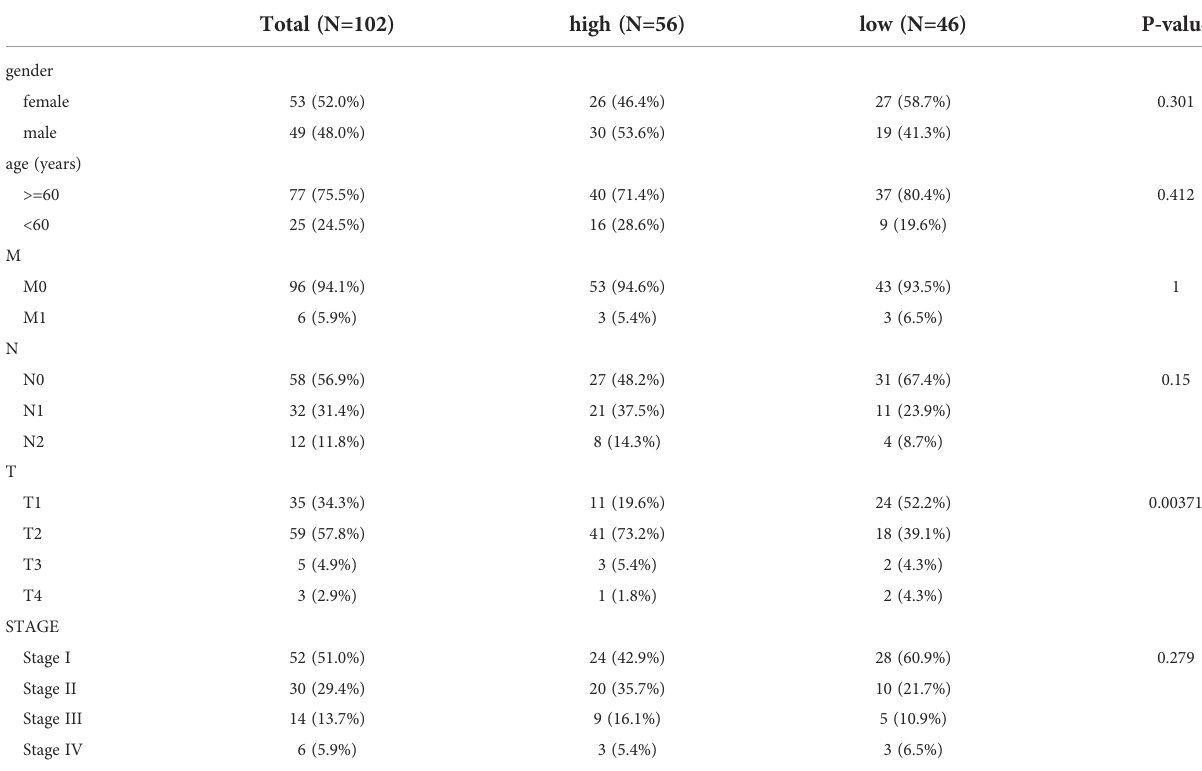
TABLE 4 Characteristics of patients in low and high risk groups in TCGA-LUAD cohort.